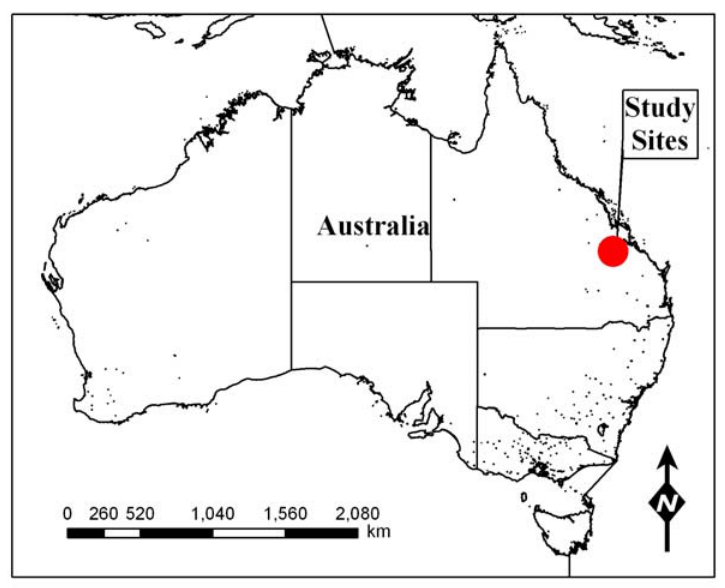
Figure 1. Location of WSN activities at the Belmont Research Station, near Rockhampton (Qld.) Australia, and a nearby study site at Pondicherry. (Spatial data source: Geoscience Australia,